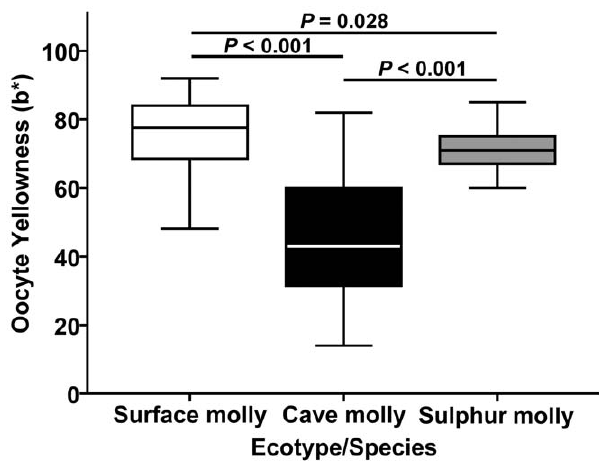
Figure 4. Ovum yellowness as a proxy for carotenoid content. Measured as the b* component of the CIE l*a*b* colour mode in Adobe (cid:2) Photoshop (cid:2) CS5. Box plots (median and IQR). Yellowness was measured for all stages combined since a preliminary ANCOVA revealed that developmental stage was not correlated with ovum yellowness. Surface mollies, N =72; cave mollies, N =47; sulphur mollies, N =50.